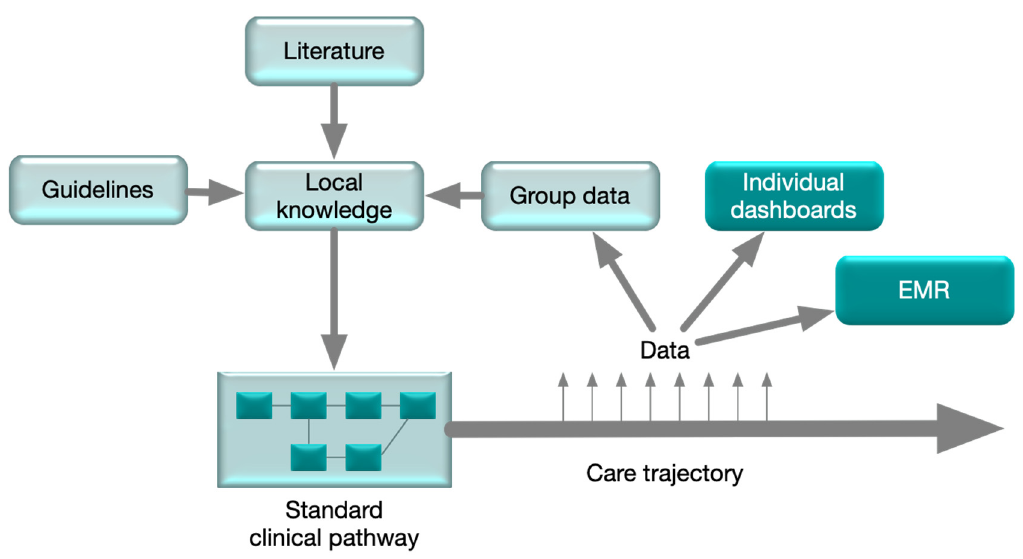
Figure 2. The standard clinical pathway was constructed based on national guidelines and evidence from the literature. During the execution of the plan, data is registered to the EMR and the individual data dashboard that supports the care in the interprofessional group. Data can also be collected on the group level and be used to update the local standard clinical pathway. Patient reported data was included as important potential modifiers of the standard clinical pathway.